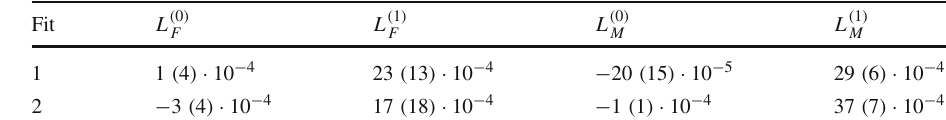
Table 8 Values for the LECs from the fits in Tables 6 and 7